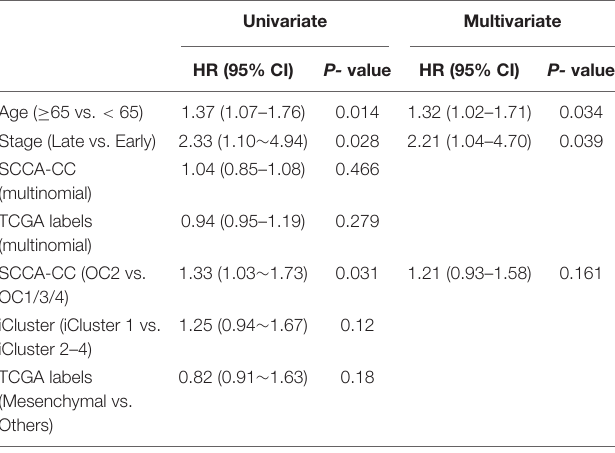
TABLE 1 | Univariate and multivariate Cox regression analyses in ovarian cancer using the TCGA dataset. Univariate Multivariate